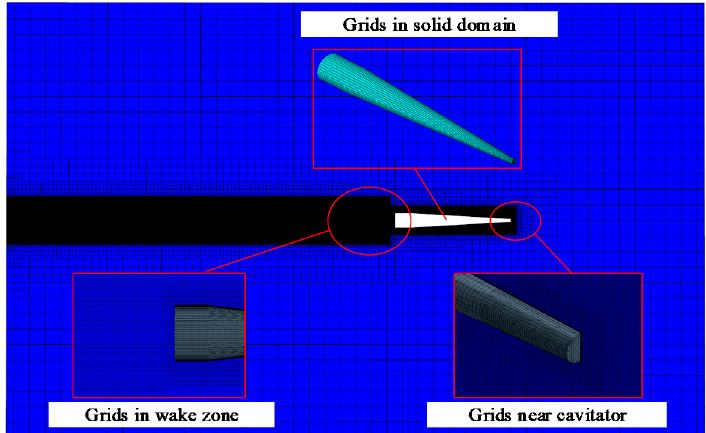
Figure 4. Distribution of grids in fluid and solid domain.